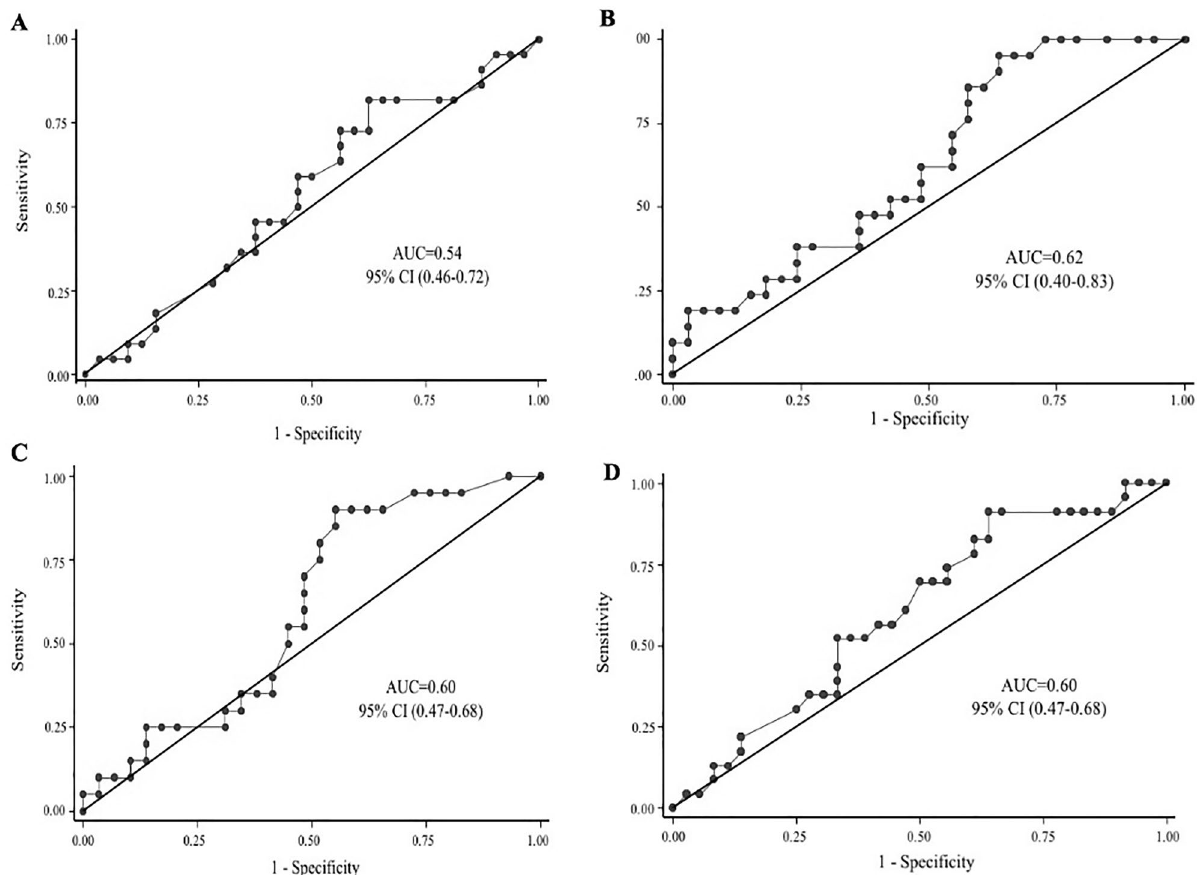
Figure 3. Subgroup analysis of area under the receiver operator characteristics curve with 95% confidence interval for the cardiovascular magnetic resonance model to detect increased pulmonary vascular resistance (≥ 3 WU). ( A ) Left ventricular ejection fraction less than 30%. ( B ) Left ventricular ejection fraction more or equal to 30%. ( C ) Depressed right ventricular ejection fraction. ( D ) Preserved right ventricular ejection fraction. AUC area under the receiver operator characteristics curve, CI confidence interval, CMR cardiovascular magnetic resonance, PVR pulmonary vascular resistance, RHC right heart